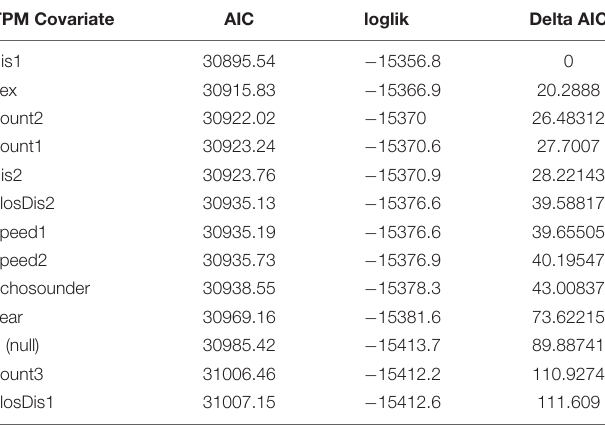
TABLE 3 | AIC, log-likelihood and delta AIC values for 4-state models that include a single covariate on the state transition probability matrix.